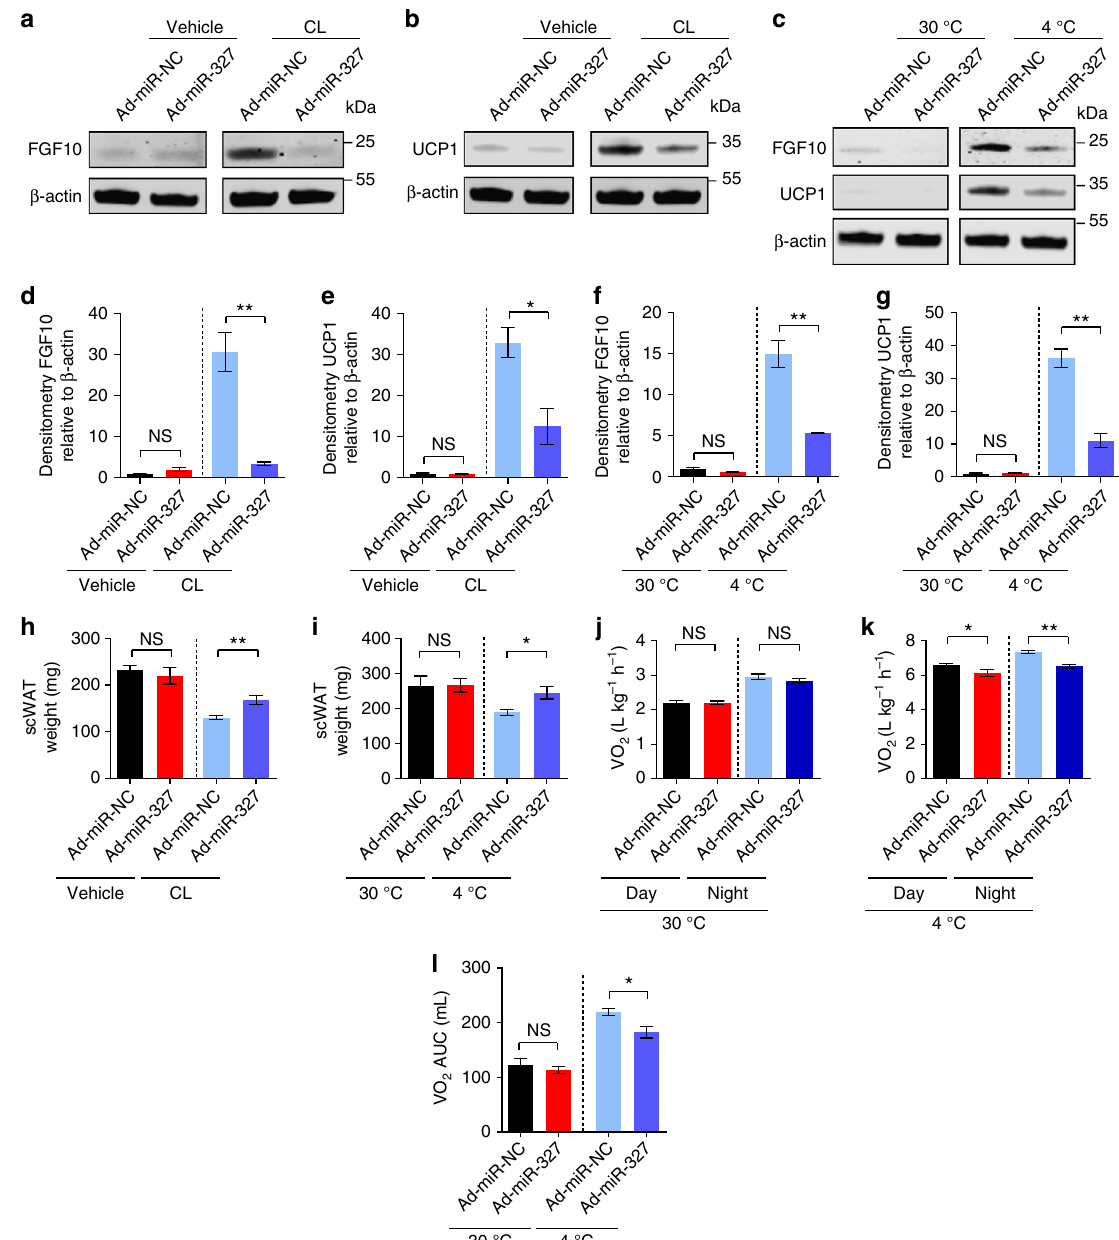
Fig. 8 miR-327 overexpression leads to reduced oxygen consumption in cold-exposed mice. a – g Western immunoblot analysis and quanti fi cation of FGF10 and UCP1 of Ad-miR-NC- and Ad-miR-327- treated scWAT derived from 5-days vehicle or CL-316243-treated and 2-week 30 °C or 2-week 4 °C exposed NSG mice. FGF10 and UCP1 protein levels were quanti fi ed as densitometric signals and normalized to β -actin ( n = 4 samples per group). h , i Depot weights of Ad-miR-NC- or Ad-miR-327-treated scWAT dissected from CL-316243-treated (5 days) and 4 °C- or 30 °C-treated (2 weeks) NSG mice ( n = 12 mice per group) j , k Oxygen consumption of Ad-miR-NC- and Ad-miR-327-treated NSG mice under 30 °C or 4 °C for 2 weeks. Oxygen consumption was measured during the resting phase (Day) and active phase (Night) ( n = 6 mice per group). l Norepinephrine (NE)-stimulated thermogenesis of Ad-miR- NC- and Ad-miR-327-treated mice after 2-week 30 °C or 4 °C exposure. Oxygen consumption is presented as area under curve (AUC) ( n = 4 mice per group). Immunode fi cient NSG mice were used for all experiments in this fi gure. kDa, kilodalton. NS, not signi fi cant. * P < 0.05, ** P < 0.01, and *** P < 0.001 by Student ’ s t -test. Data presented as mean ±